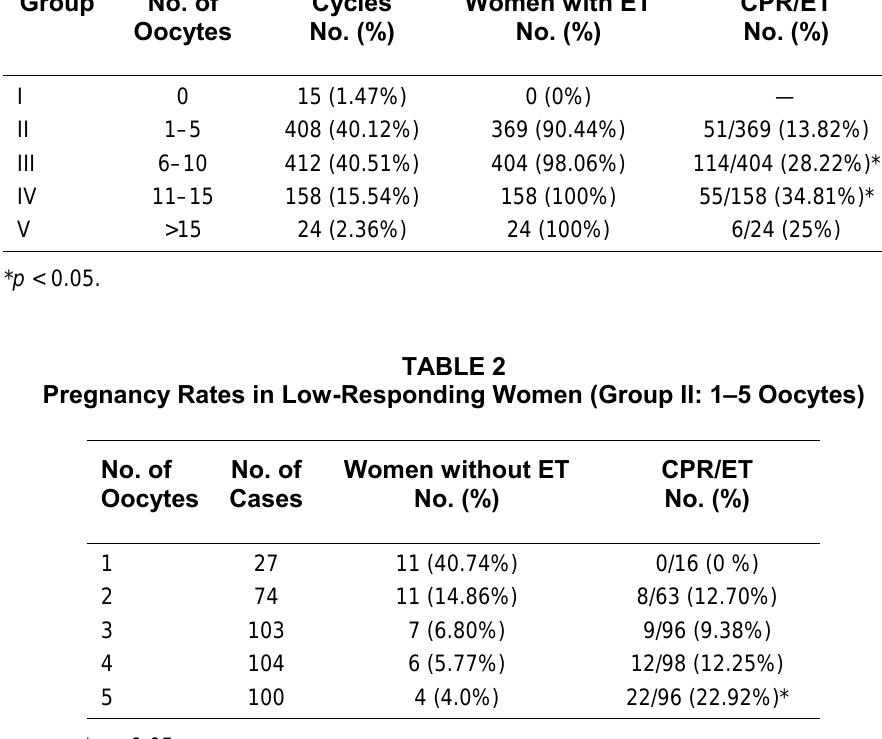
Clinical Pregnancy Rate After IVF/ICSI, According to the Number of Retrieved Oocytes Group